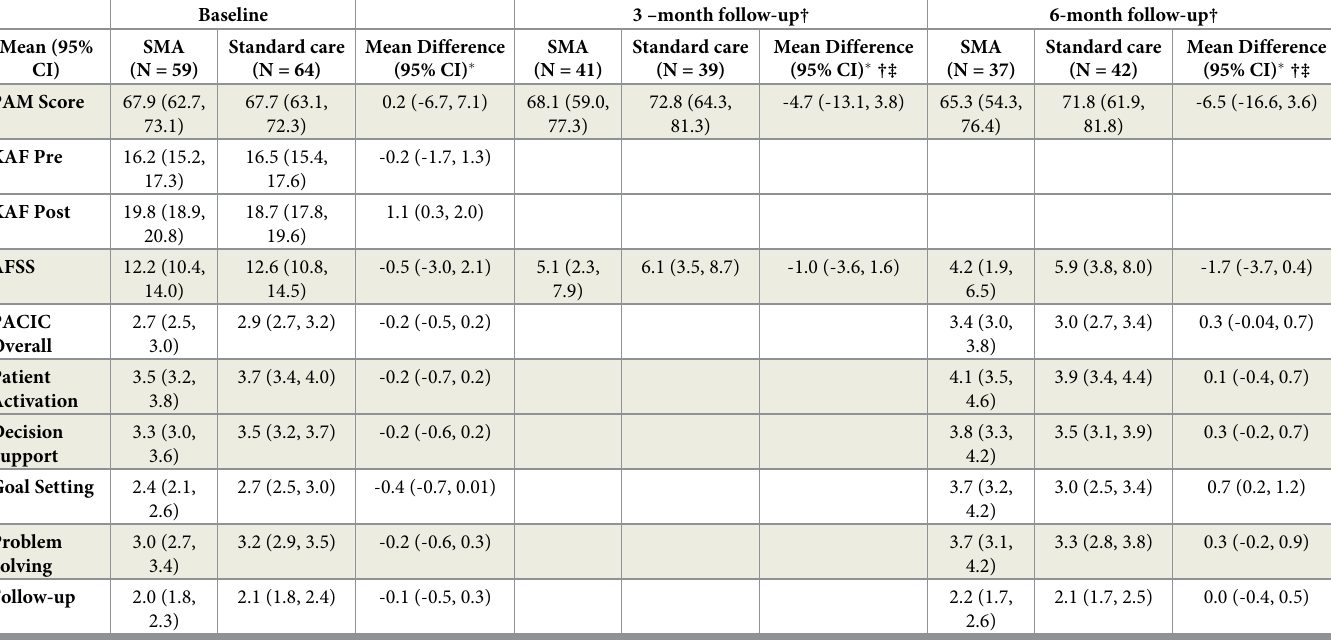
Table 4. Patient reports of outcomes collected at prior to pre- catheter ablation appointment, immediately following pre- catheter ablation appointment, 3-months post catheter ablation, and 6-months post catheter ablation.